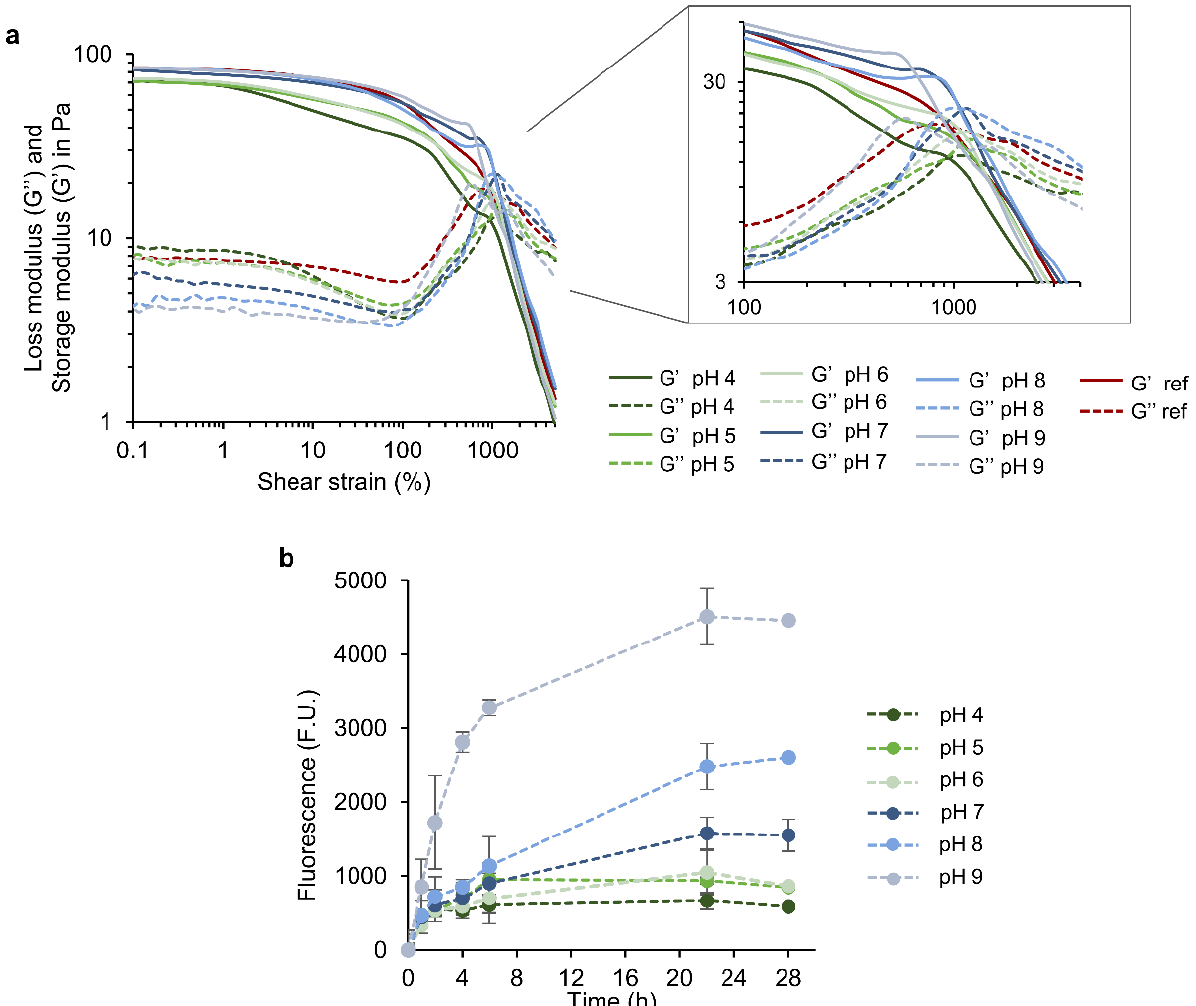
Figure 4. pH responsiveness of the hydrogels. ( a ) Rheological stability of the hydrogels after incubation at different pH values measured using an oscillatory test (frequency 1 s − 1 , shear strains 0.1 – 10,000%). For simplification, one representative sample per experimental group (n = 3) is shown. ( b ) Release of PLN from the hydrogels incubated at different pH. The results are presented as mean fluorescence values (n = 3) ± SD.